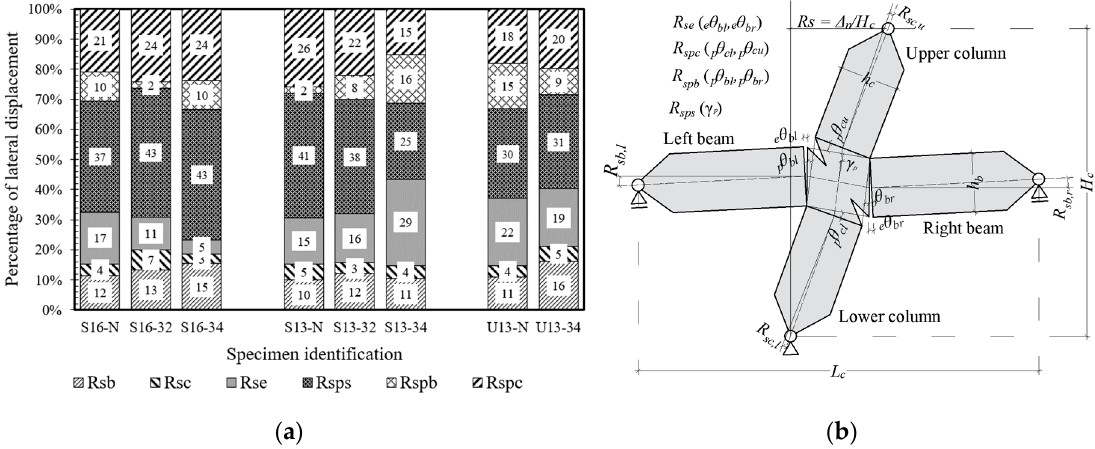
Figure 12. Decomposition of the lateral drift of the interior beam–column joint: ( a ) percentage of deformation for Groups 1, 2, and 3 at a lateral drift of 3.5%; ( b ) deformation